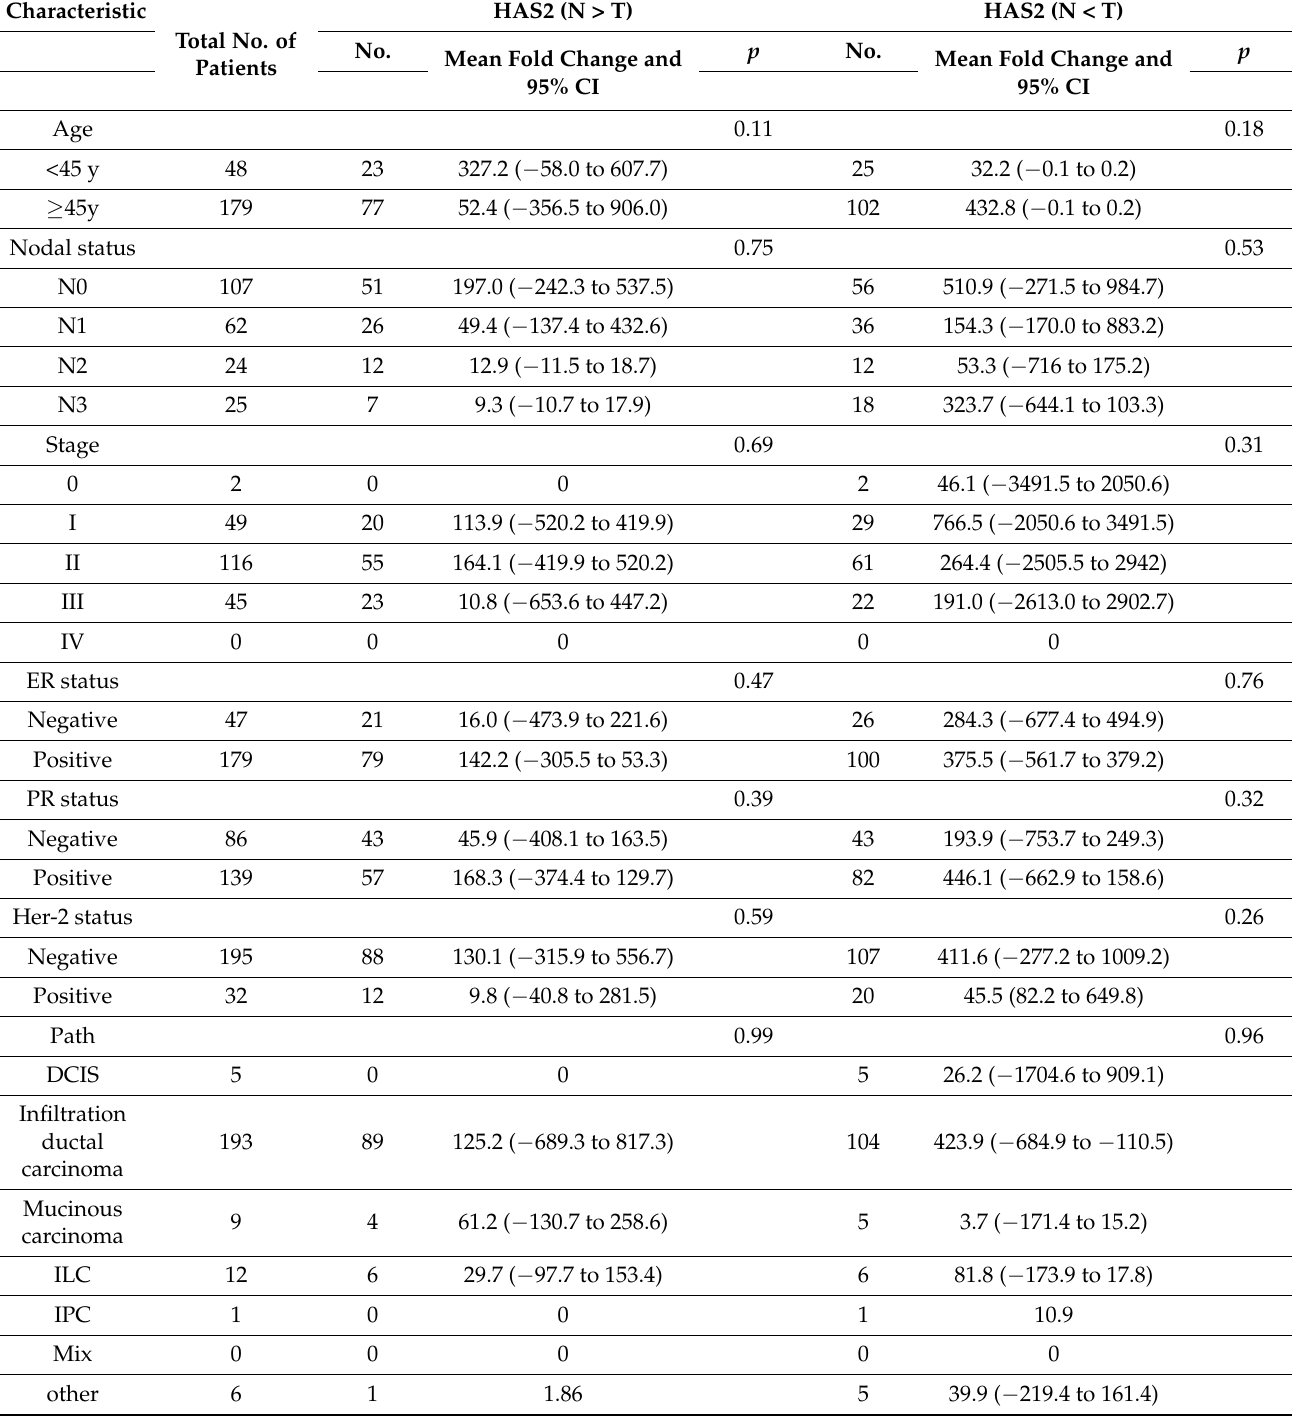
Table 2. Demographic evaluation of clinical criteria and HAS2 mRNA expression fold changes between tumor vs. normal paired